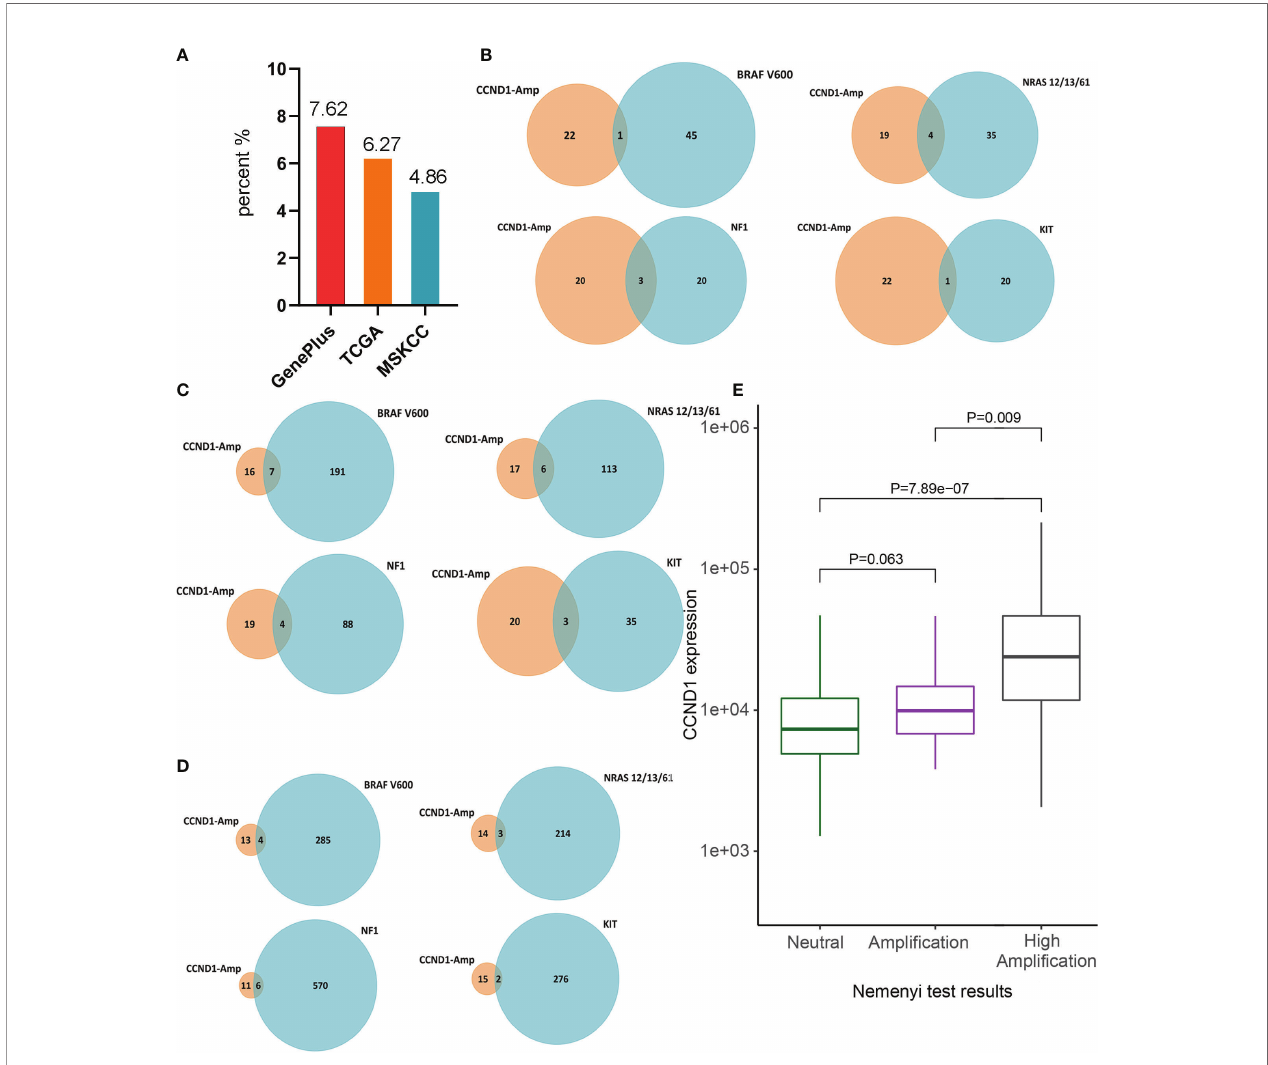
FIGURE 1 | Prevalence of CCND1 ampli fi cation in melanoma. (A) The prevalence of CCND1 ampli fi cation calculated using data from Chinese patients with melanoma analyzed by Geneplus ( n =302) and using data from the TCGA ( n =367) and MSKCC ( n =350) databases. (B) The frequency of co-occurrence of CCND1 ampli fi cation with BRAF V600 , NRAS , NF1 , KIT in samples from Chinese patients with melanoma analyzed by Geneplus. The frequency of co-occurrence of CCND1 ampli fi cation with BRAF V600 , NRAS , NF1 , KIT in samples from the (C) TCGA and (D) MSKCC databases. (E) CCND1 mRNA expression in the CCND1 Neutral group ( n =191), Ampli fi cation group ( n =46) and High Ampli fi cation group ( n =23) in samples from the TCGA database. MSKCC, the Memorial Sloan Kettering Cancer Center; TCGA, The Cancer Genome